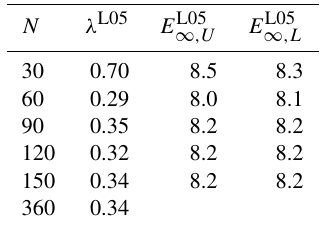
Table 2. Values of the largest global Lyapunov exponents λ L05 and limit values of predictability curves E L05 ∞ played number of variables N of the L05